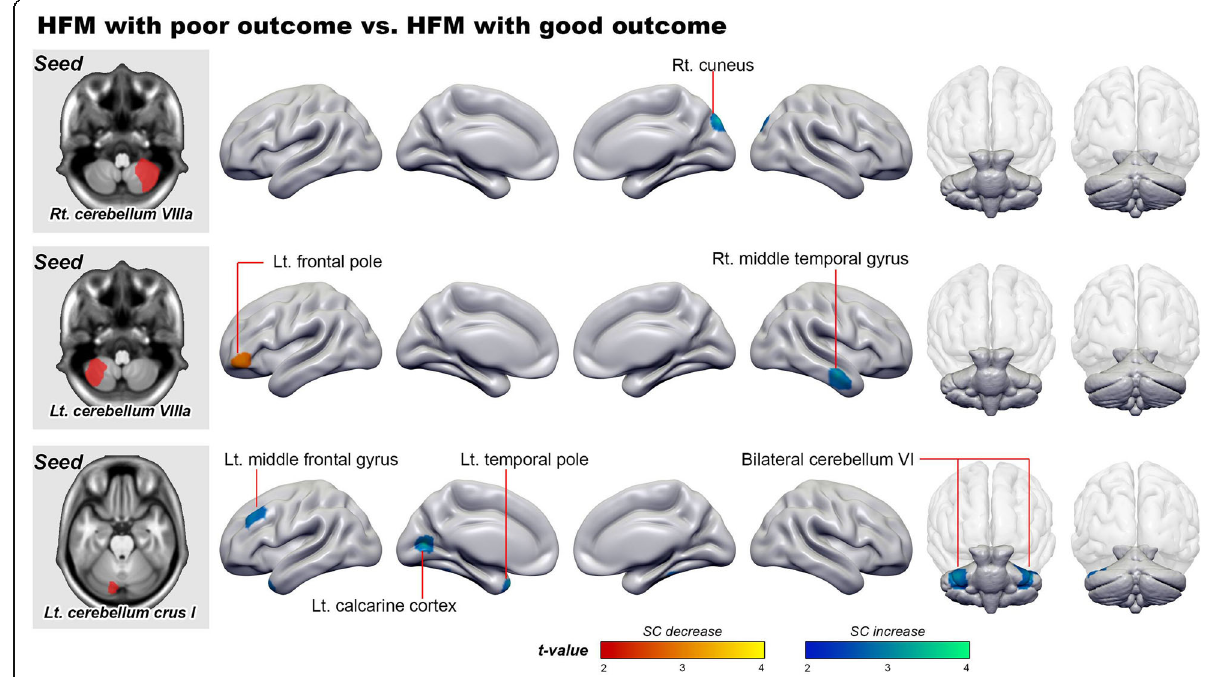
Fig. 2 Three cerebellar seeds and the changes in the structural covariance (SC) network from the three seeds to the whole brain between patients with different outcomes. The blue and red markers are regions that displayed different SC with the seeds between the outcome